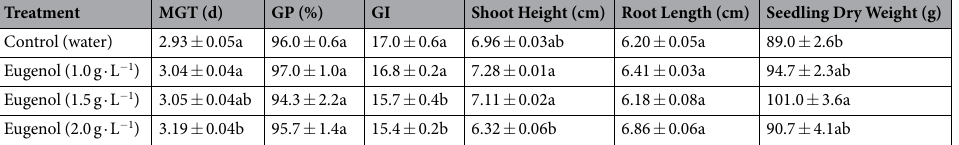
Table 1. Effects of different concentrations of eugenol on seed germination and seedling characteristics of hybrid rice Qian You 1. Each value represented the mean (n = 3); small letters following the values within each column indicated significant differences ( α = 0.05, LSD) among control and eugenol treatments.